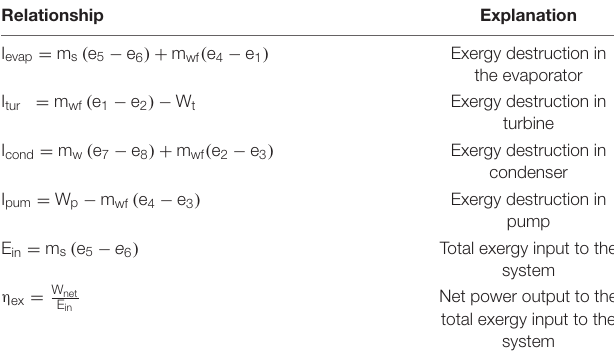
TABLE 4 | Important formulas used for exergy analysis. Relationship Explanation TABLE 5 | Values of constant K used to calculate the base module cost (Turton